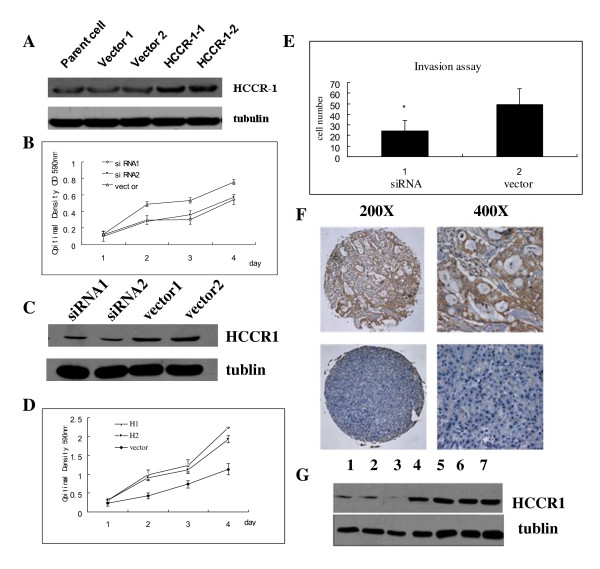
Overexpression of HCCR-1 induces the proliferation of PANC-1 cells. A) PANC-1 cells were transfected with control empty vector and HCCR-1 gene. B) HCCR-1 accelerated the proliferation of PANC-1 cells by 1.5 fold compared to control. The measurement of proliferation rate was performed by MTT assay. Values represent the mean ± SEM, Groups with annotations of H1 and H2 are significantly different with Vector, P < 0.01, two-way ANOVA. C) PANC-1 cells were transfected with HCCR-1 siRNA and control empty vector. D) Knock-down of HCCR-1 decreased the proliferation of PANC-1 cells MTT assay. Values represent the mean ± SEM, Groups with annotations of siRNA were significantly different with Vector, P < 0.01, two-way ANOVA. E) The invasiveness of HCCR-1 siRNA and vector transfectants were assessed by incubating cells in transwell plates(Costar) with polycarbonate filters for 24 h using 10% FBS as a chemoattractant. Cells invaded through the matrigel and filtered to the lower surface were fixed with 4% neutral-buffered formalin and stained with Giemsa. The number of invasion cells was significantly lower in HCCR-1 siRNA transfectants (24.4 ± 9.9) than in vector control(49.1 ± 15.4), *P < 0.01. Each experiment was repeated for three times. F) Immunohistochemical staining of pancreatic cancer tissues on a tissue chip. Strong straining of HCCR-1 in a pancreatic carcinoma(the upper two pictures). Expression of HCCR-1 in a paraneoplastic tissue(the two pictures below). The staining was graded according to Allred score system. G) The expression of HCCR-1 was analyzed by performing western blotting in the same tissues used in immunohistochemical staining. Lanes 1 to 3, paraneoplastic tissues; lanes4 to 7, pancreatic tumor tissues. Tubulin was used as a loading control.